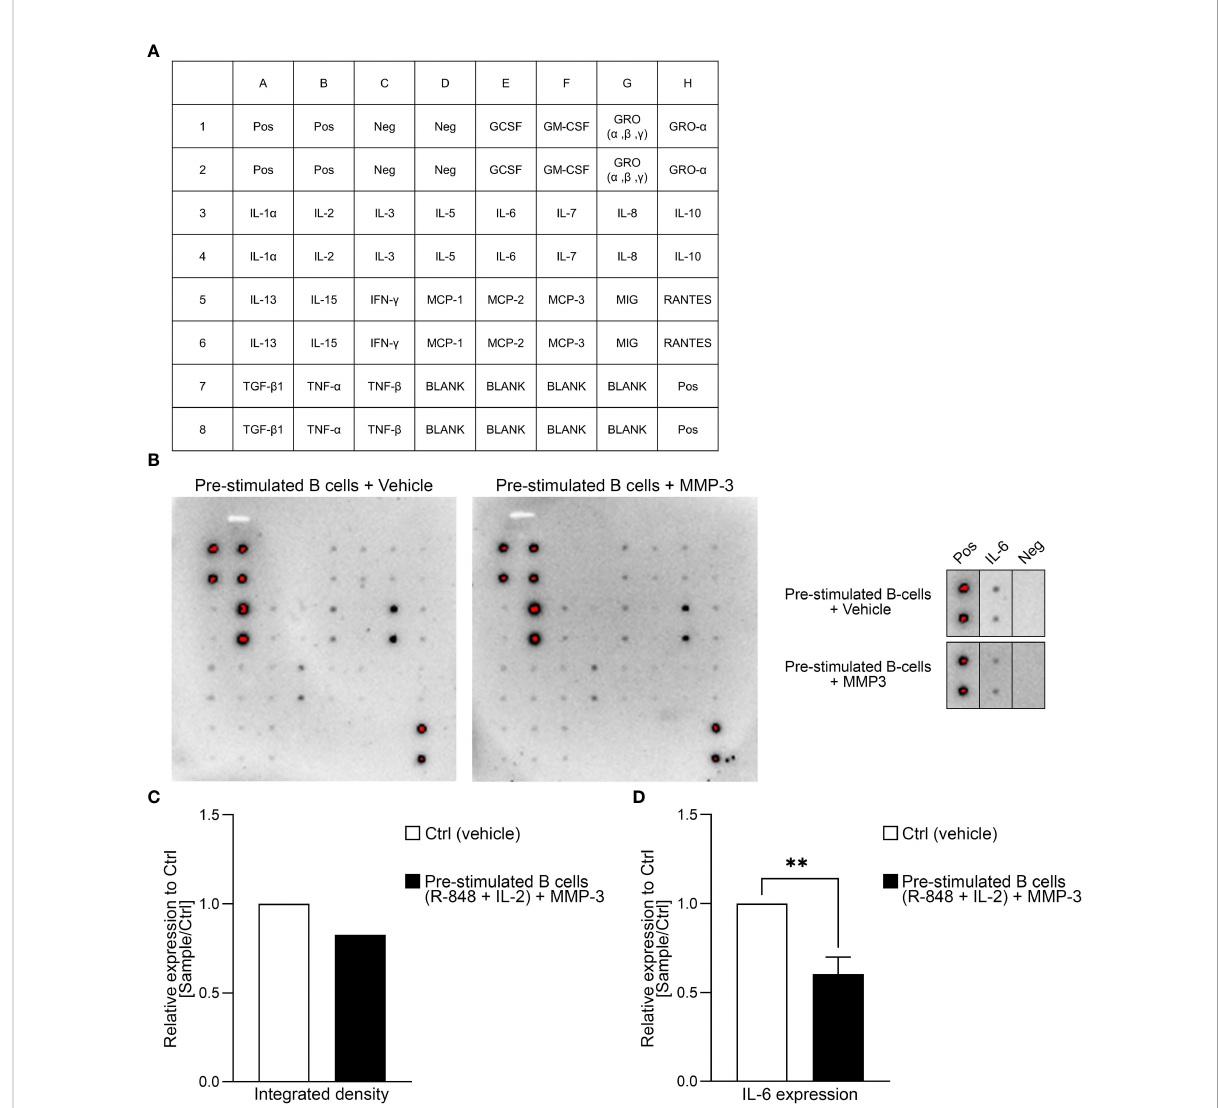
FIGURE 4 Cytokine pro fi ling of MMP3-treated B cells. (A) Layout of the antibody array used for investigating cytokines. (B) The dot blot indicates the cytokine expression pro fi le of pre-stimulated B cells after treatment with either MMP-3 or vehicle from one representative donor. Additionally, IL-6 production by B cells from the same donor is highlighted. (C) Relative amount of IL-6 production by pre-stimulated B cells treated with MMP-3 compared to vehicle was calculated by using integrated density from n = 1 donor, measured in duplicates. (D) Relative IL-6 production of pre-stimulated B cells ( n = 9 healthy donors), measured by ELISA. Bars display mean values + SEM, ** p < 0.01, paired t test. Pos, positive control; Neg, negative